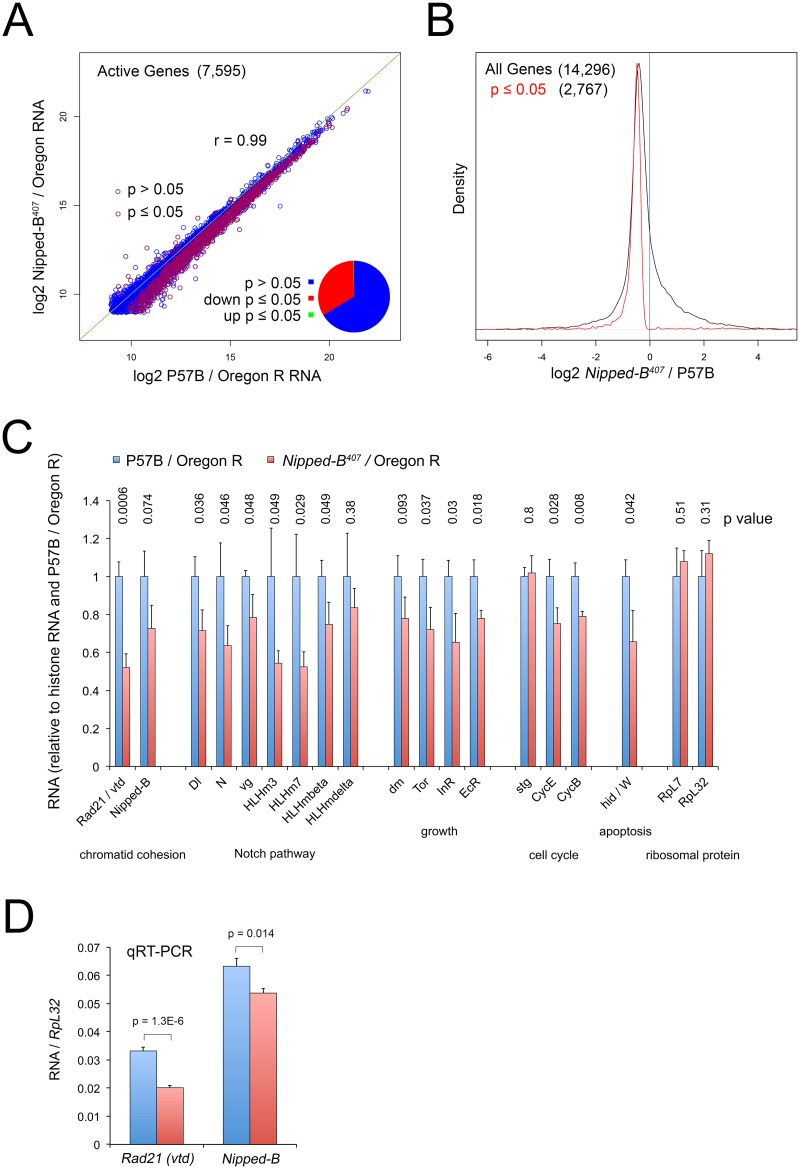

Nipped-B mutant wing discs show broadly reduced gene expression by RNA-seq analysis.(A) Plot of expression level of all active genes in matched wild-type controls (P57B / Oregon R) versus Nipped-B
407 / Oregon R 3rd instar wing discs. RNA-seq was performed using ribosomal RNA depletion and normalization to histone RNA to compensate for the broad effects of Nipped-B on gene transcription [24]. Active genes (7,595) were defined as those averaging more than 500 nucleotides of sequence coverage between replicates. Pearson correlation coefficients between replicate samples for all genes quantified (14,296) ranged from 0.96 to 1.00, indicating high reproducibility (S1 Table). The green line indicates a slope of 1, revealing that the Nipped-B mutants show diminished expression of many genes. Red circles indicate genes in which the change in RNA levels have a p value ≤ 0.05, which represent roughly a third of active genes as shown by the pie chart. (B) Density distribution plots of the fold-changes in gene expression between Nipped-B mutants and the wild-type control (log2 Nipped-B
407 / P57B ratio) for all genes (black) and those genes for which the change has a p value ≤ 0.05. The number of genes in each group is indicated in parentheses. This shows that relative to histone RNA levels, most genes show lower RNA levels in the Nipped-B mutant wing discs, and that most statistically significant changes are decreases in expression. (C) Examples of expression changes for selected genes. The blue bars are set to 1 in the P57B / Oregon R control after normalization to histone RNA to allow all genes to be shown on the same scale. The error bars are the standard errors calculated from the four replicates, and p values are given above each gene. The Rad21 (vtd) cohesin subunit gene and Nipped-B both show reductions. Several genes in the Notch signaling pathway show reductions, including the Delta (Dl) ligand, Notch (N), and direct Notch targets, including vestigial (vg) and genes in the Enhancer of split complex (HLHm3, HLHm7, HLHmbeta, HLHmdelta). Several genes that regulate growth also show reductions including dm (myc), Tor, the insulin receptor (InR) and the ecdysone hormone receptor (EcR). The string (stg) cdc25 cell cycle control gene does not show a reduction, in contrast to the cyclin E (CycE) gene that drives S phase and the cyclin B (CycB) G2 cyclin gene. The Wrinkled (W, hid, head involution defective) pro-apoptosis gene shows a significant decrease. The RpL32 and RpL7 ribosomal protein genes, which are often used as normalization controls for qRT-PCR experiments and Northern blots, do not show significant changes in expression. The expression values for all genes in the RNA-seq analysis are in S1 Table, along with the ontology analysis indicating that pathways involved in development, morphogenesis and growth are broadly affected, although the only significant phenotype in adult Nipped-B mutant wings is the reduced cell number and size. (D) qRT-PCR validation of the effects on Rad21 (vtd) and Nipped-B RNA levels in 3rd instar wing discs, normalizing to RpL32 RNA levels. Ten P57B / Oregon R and eight Nipped-B
407 / Oregon R replicates were assayed. The error bars are standard error calculated from all PCR replicates, and the p values for the comparisons to the controls are indicated.